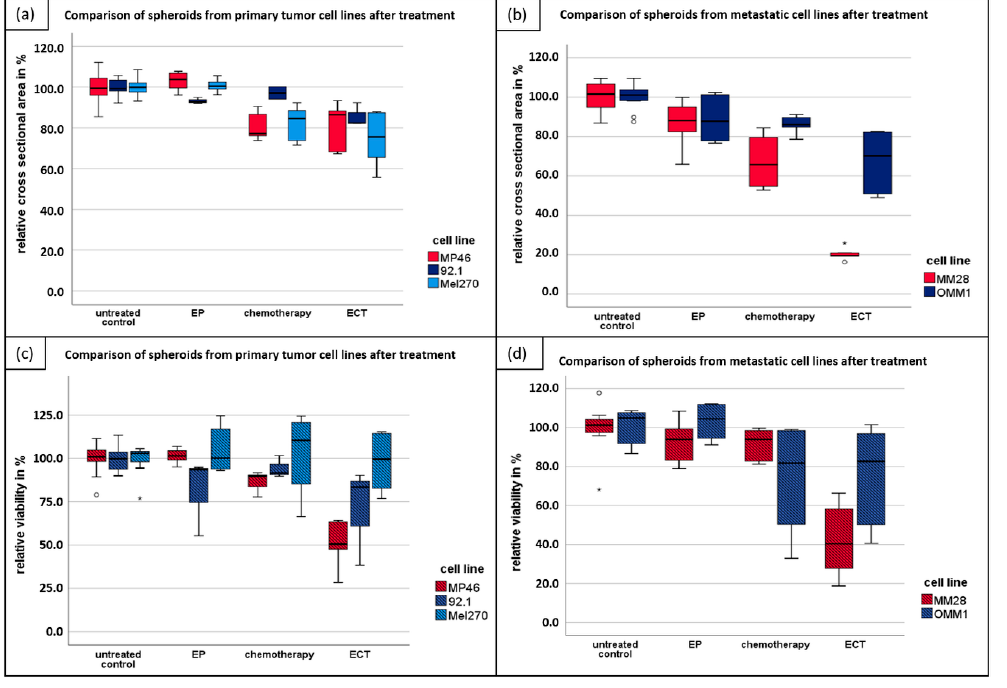
Figure 1. Electrochemotherapy (ECT, 750V/cm after application of 2.5 µg/mL bleomycin) caused Figure1. Electrochemotherapy(ECT,750V / cm afterapplication of 2.5 µ g / mL bleomycin)caused stronger stronger cytotoxic effects in spheroids of UM cell lines compared to electroporation (EP) or cytotoxic e ff ects in spheroids of UM cell lines compared to electroporation (EP) or chemotherapy using chemotherapy using bleomycin (2.5 µg/mL) alone. The cytotoxic effect was measured by calculating bleomycin (2.5 µ g / mL) alone. The cytotoxic e ff ect was measured by calculating both the cross-sectional both the cross-sectional area and MTT assay as a percentage of the untreated control seven days after area and MTT assay as a percentage of the untreated control seven days after treatment. Box plots show treatment. Box plots show ( a ) the mean cross-sectional area of spheroids from primary UM cell lines; ( a ) the mean cross-sectional area of spheroids from primary UM cell lines; ( b ) the mean cross-sectional ( b ) the mean cross-sectional area of spheroids from metastatic UM cell lines; ( c ) the mean viability of area of spheroids from metastatic UM cell lines; ( c ) the mean viability of spheroids from primary UM spheroids from primary UM cell lines; ( d ) the mean viability of spheroids from metastatic UM cell cell lines; ( d ) the mean viability of spheroids from metastatic UM cell lines. Uveal melanoma cell lines. Uveal melanoma cell lines with monosomy 3 and missing BAP1 expression are labeled in red; lines with monosomy 3 and missing BAP1 expression are labeled in red; cell lines without LOH of cell lines without LOH of chromosome 3 and verified BAP1 expression are marked in blue. Outliers chromosome 3 and verified BAP1 expression are marked in blue. Outliers with values between 1.5 and 3 times of interquartile range are marked by an “o” and extremes with values more than 3 times of interquartile range are marked by an asterisk